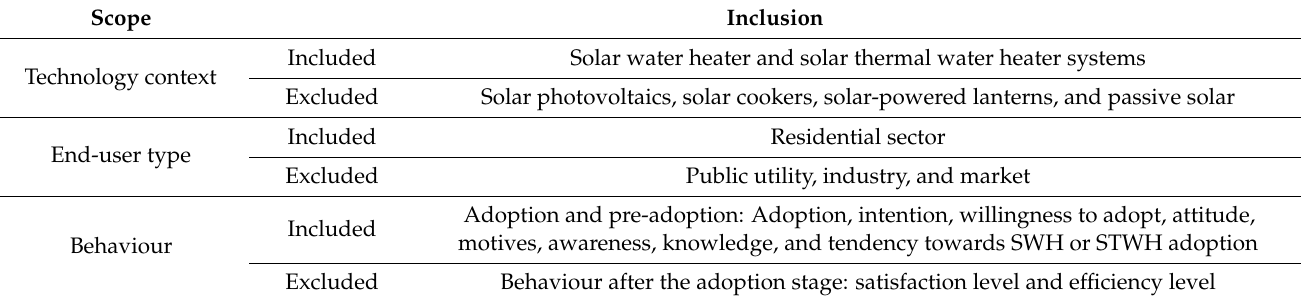
Table 1. Scope of the